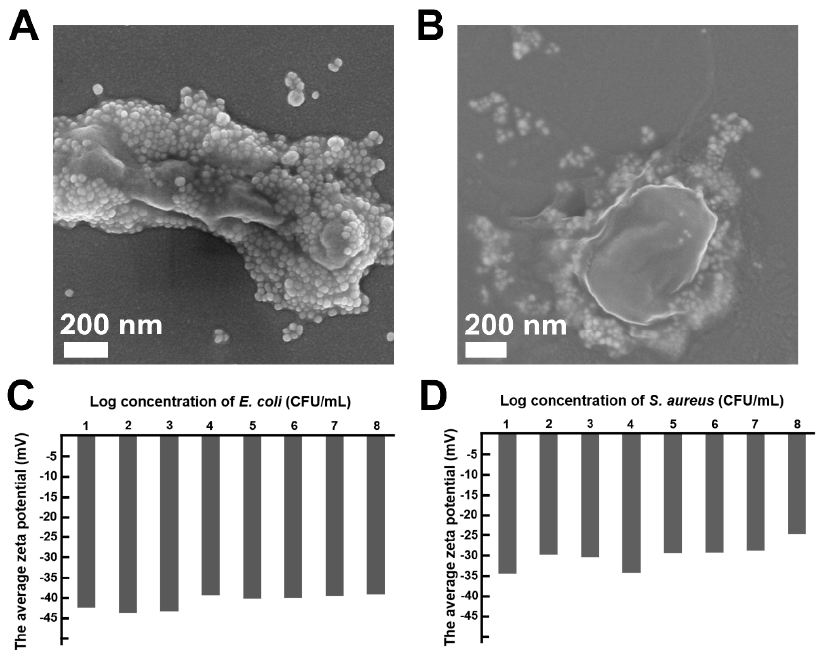
Figure 3. SEM images of ( A ) E. coli and ( B ) S. aureus anchored by Au − Azo@Ag − CTAB NPs. Surface potential of ( C ) E. coli and ( D ) S. aureus at different concentrations.